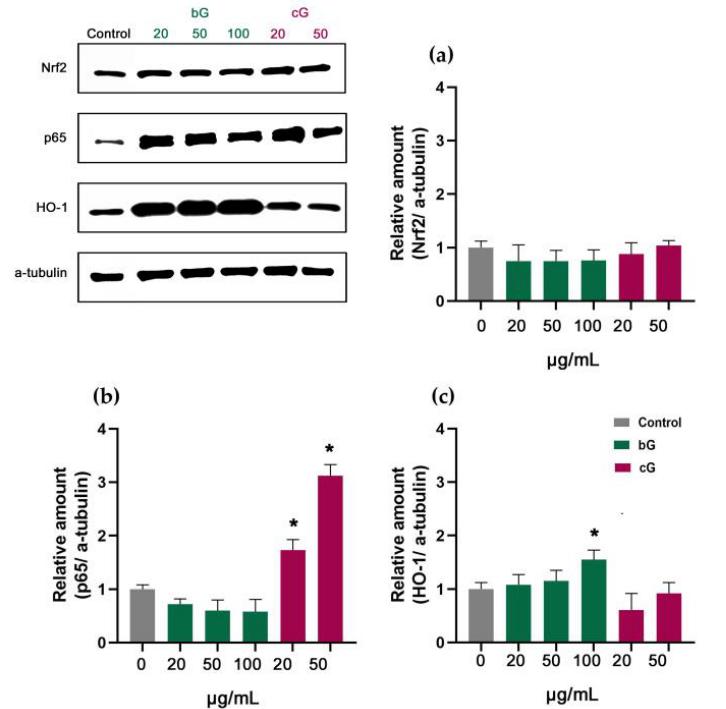
The treatment with both nanomaterials in THP-1 derived macrophages had a differ-